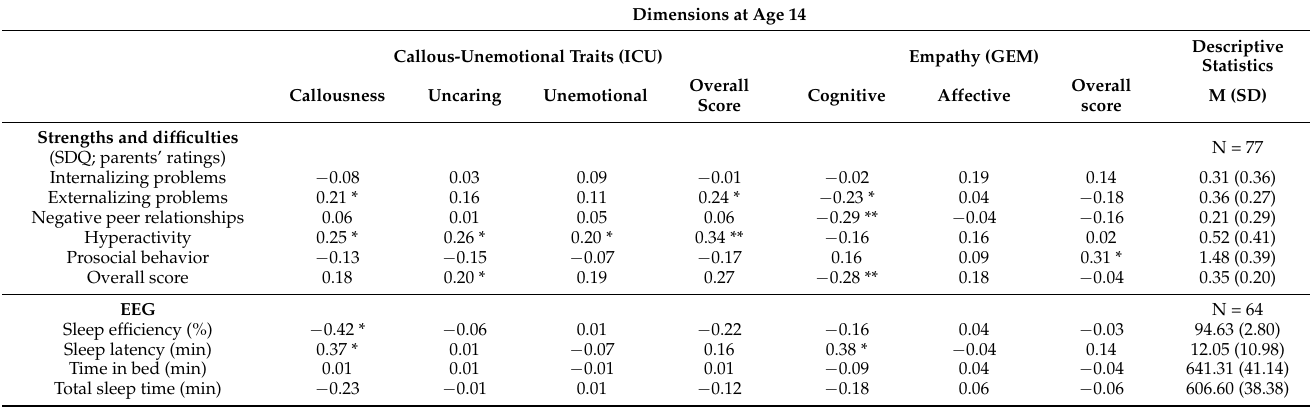
Table 1. Descriptive statistical indices (means and standard deviations) and correlations between callous-unemotional traits and empathy at age 14 and parents’ ratings of children’s psychological functioning at age five. Dimensions at Age